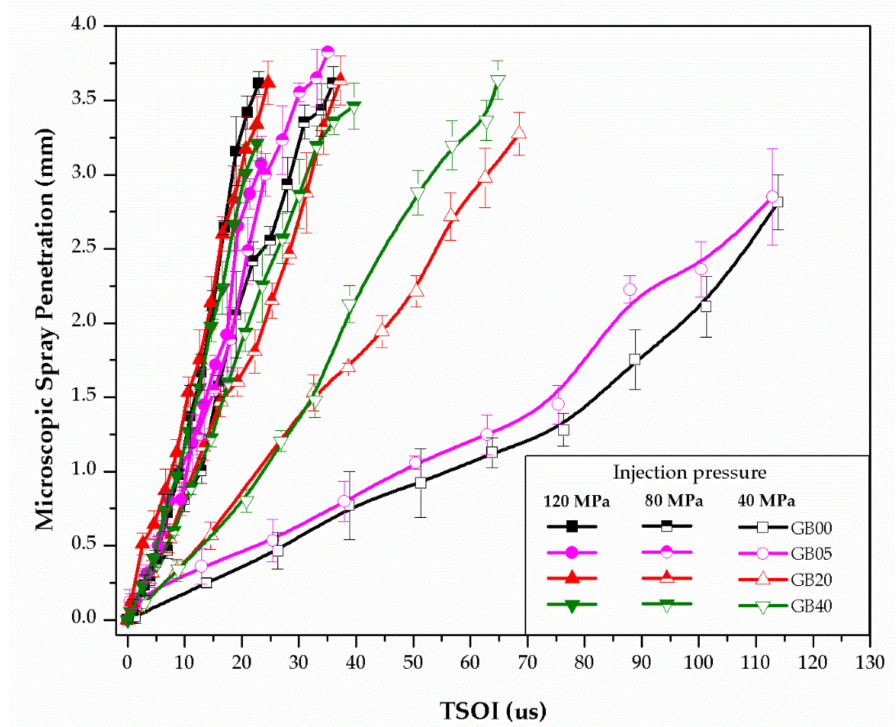
Figure 6. Microscopic spray penetration of GB fuels according to the injection pressure (GB00: gasoline 100% and biodiesel 0%, GB05: gasoline 95% and biodiesel 5%, GB20: gasoline 80% and biodiesel 20%, GB40: gasoline 60% and biodiesel